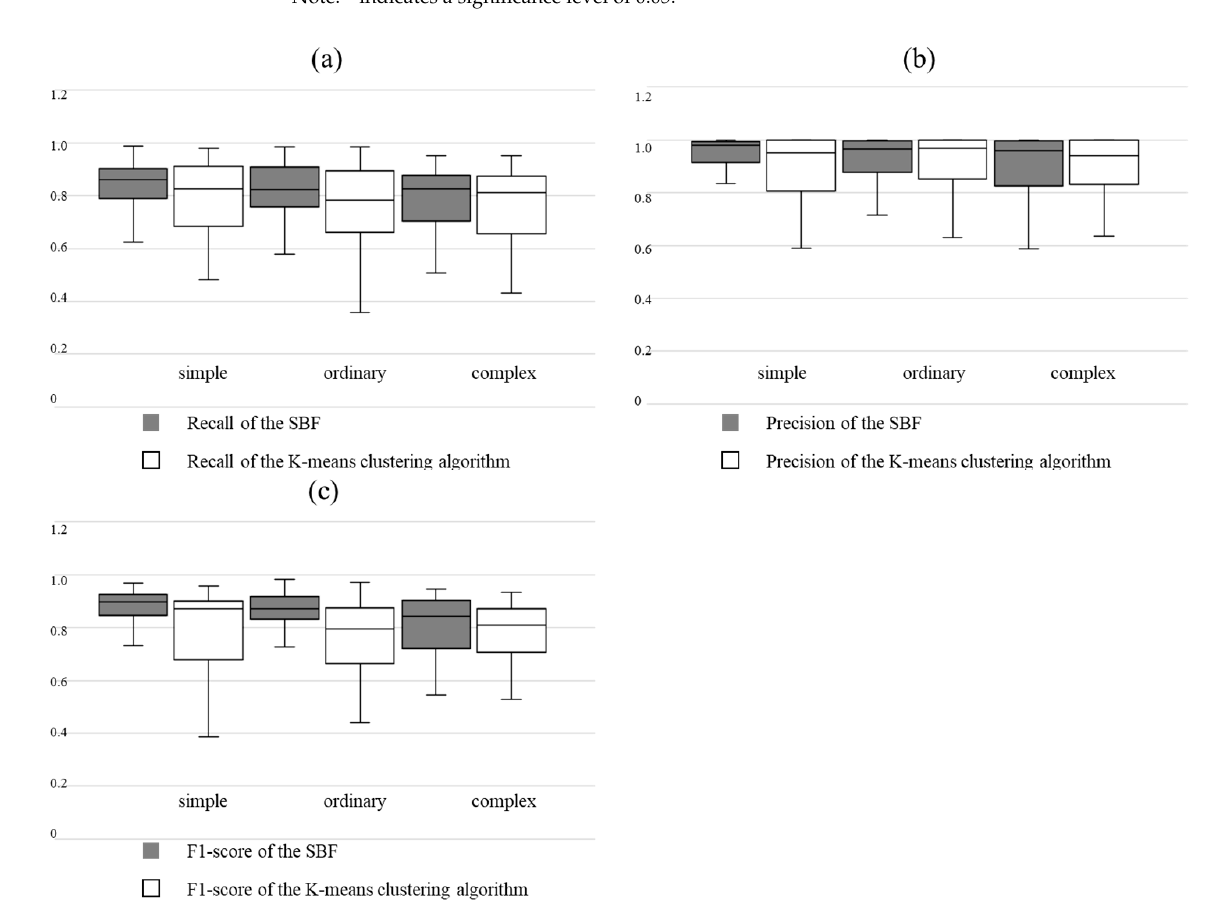
Figure 8. Box plots of the accuracy indicators between SBF and K-means clustering algorithm: ( a ) are the recall; ( b ) are the precision; ( c ) are the f1-score.